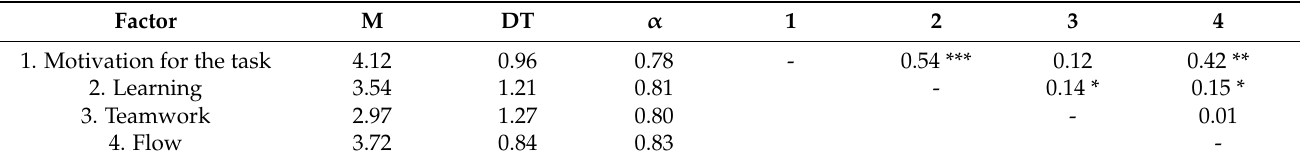
Table 2. Analysis of reliability, mean, standard deviation, and bivariate